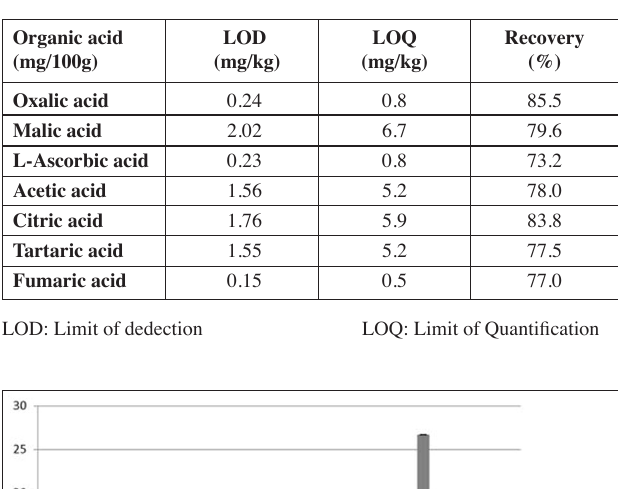
Tab. 3: Performance characteristics of the determination of organic acid method.